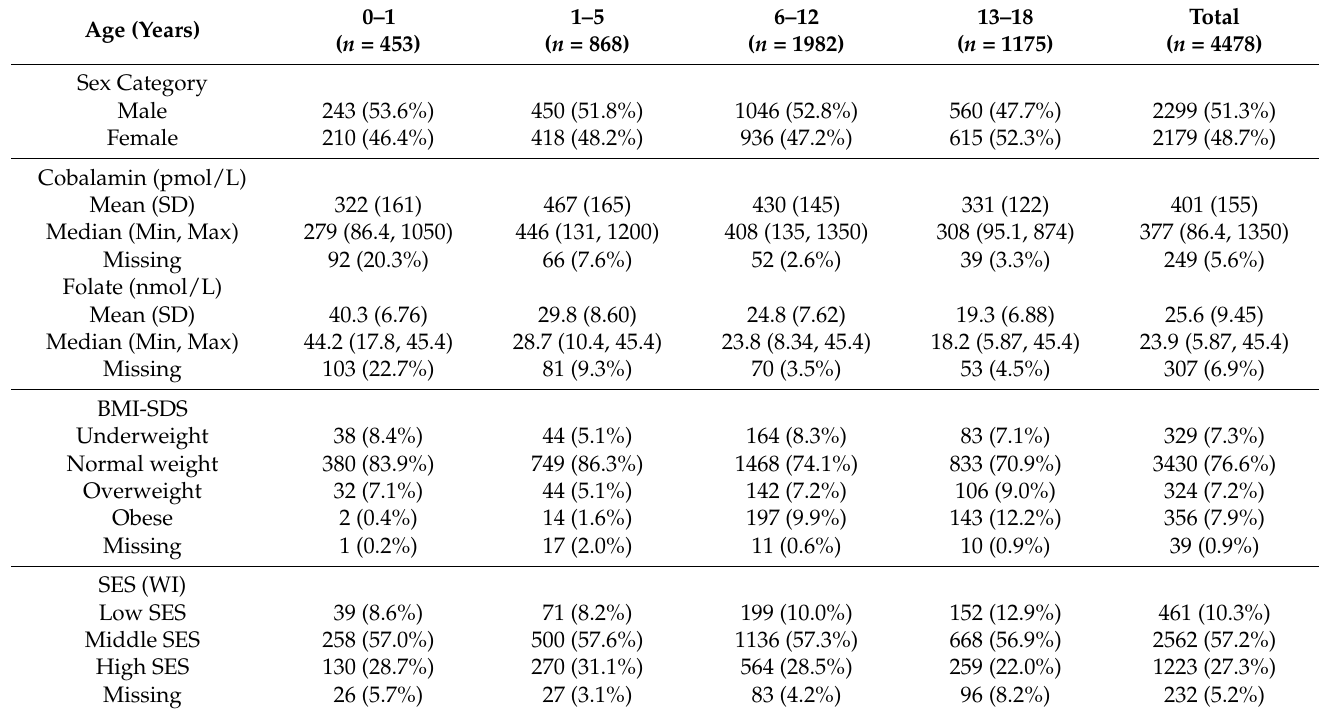
Table 1. Description of the LIFE (Leipzig Research Centre for Civilization Diseases) Child cohort stratified by age